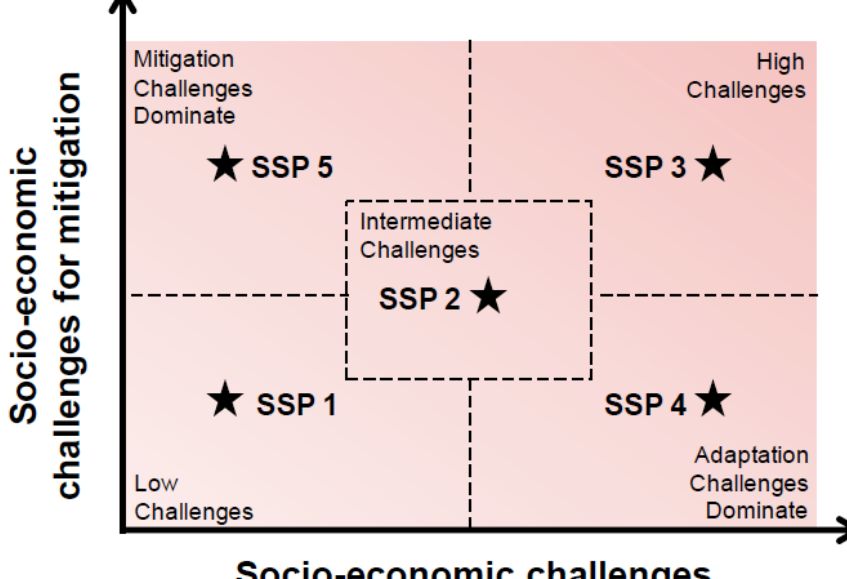
Figure 1. Challenges space for shared socioeconomic